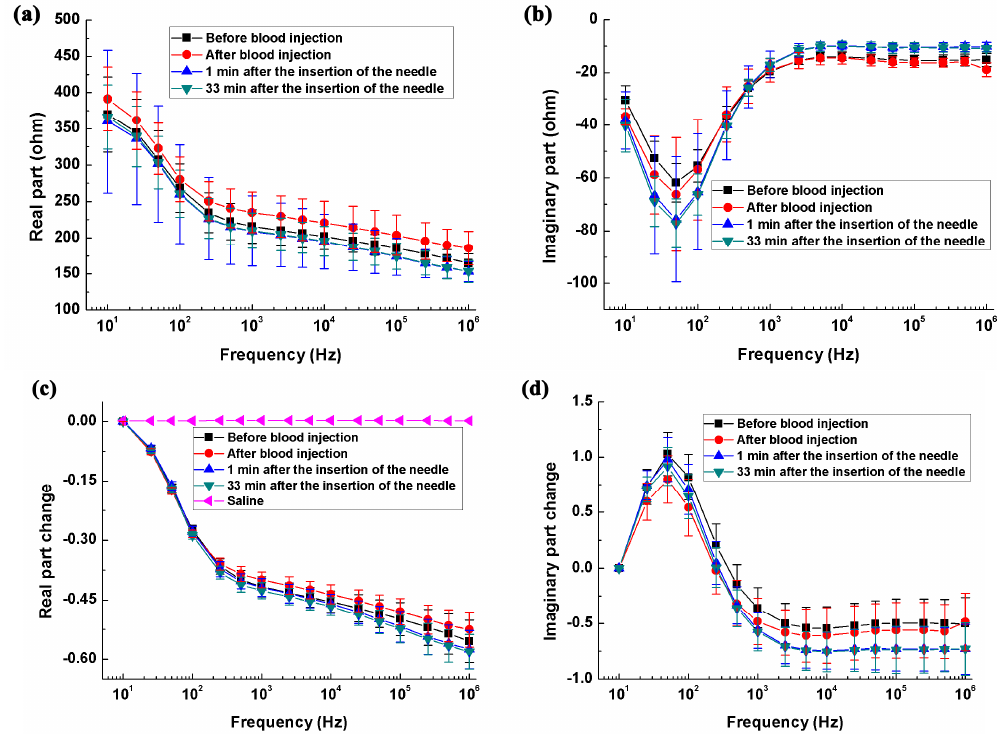
Figure 3. The brain impedance spectra of the intracerebral hemorrhage group and its control group. ( a , b ) Real and imaginary parts of brain impedance spectra; ( c , d ) The changes in the real and imaginary parts of brain impedance relative to the impedance at 10 Hz.